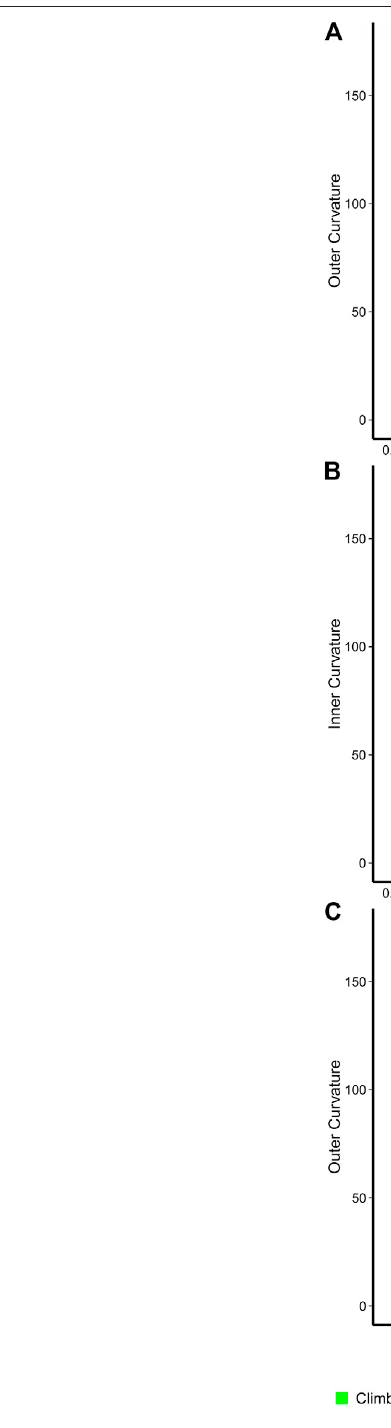
Frontiers in Earth Science |